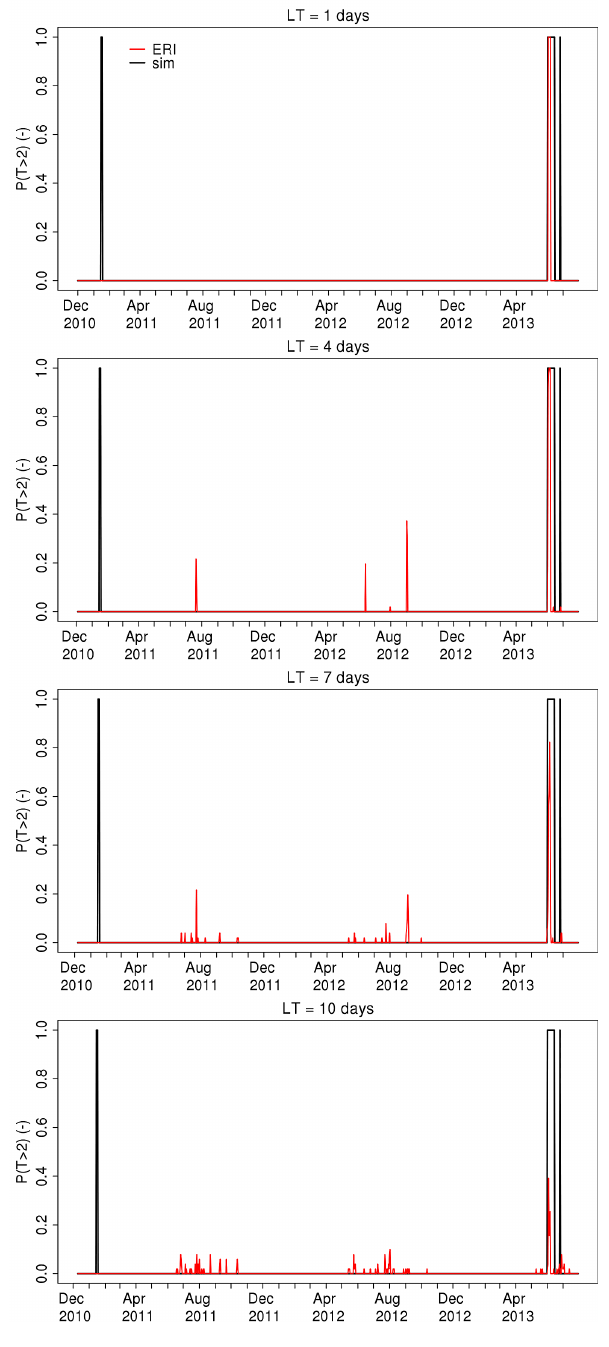
Figure 2. Forecast (ERI) and simulated (sim) exceedance of the 2- year discharge return period for the Danube River at Linz, Austria. From top to bottom, LT = 1, 4, 7, and 10days.